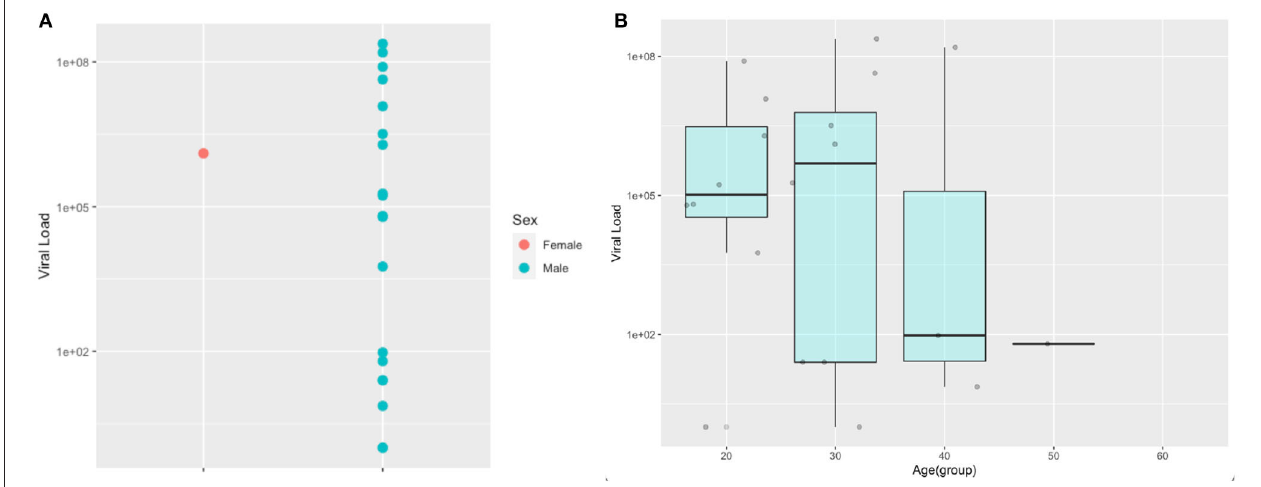
FIGURE 4 | Viral load distribution for SARS-CoV-2 police officers according to sex (A) and age groups (B)